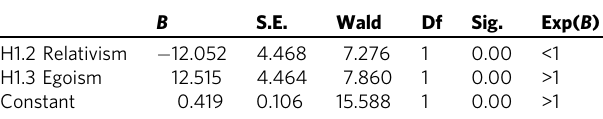
Table 5 Equation